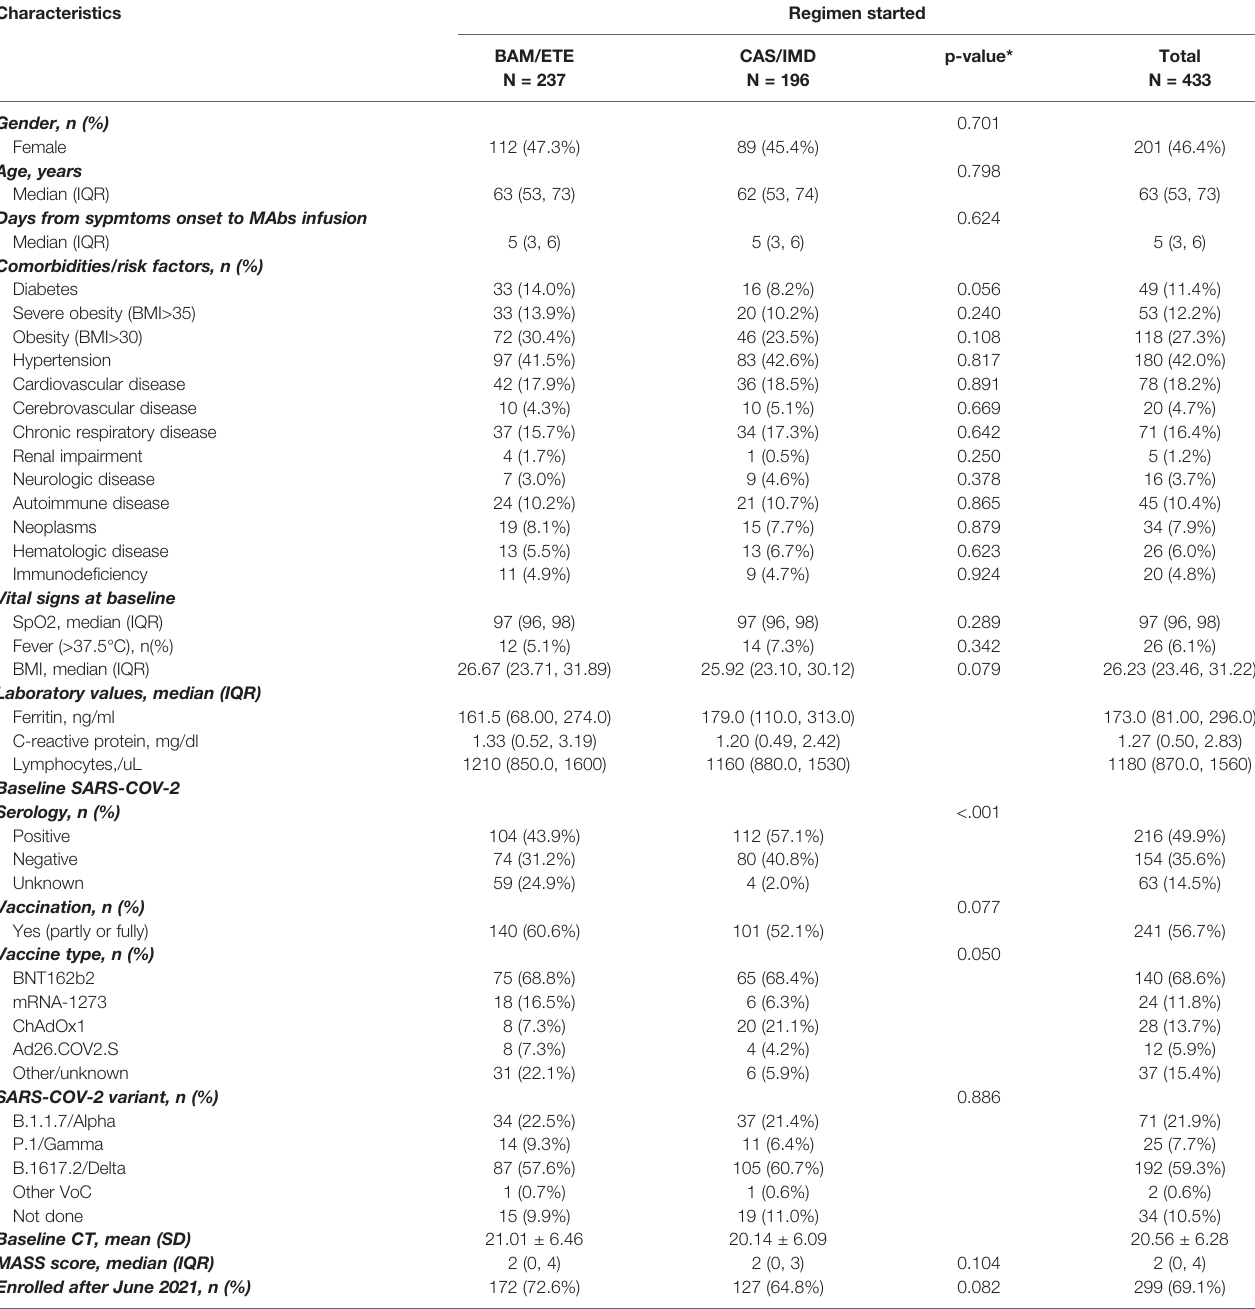
TABLE 1 | Main characteristics at enrolment by intervention